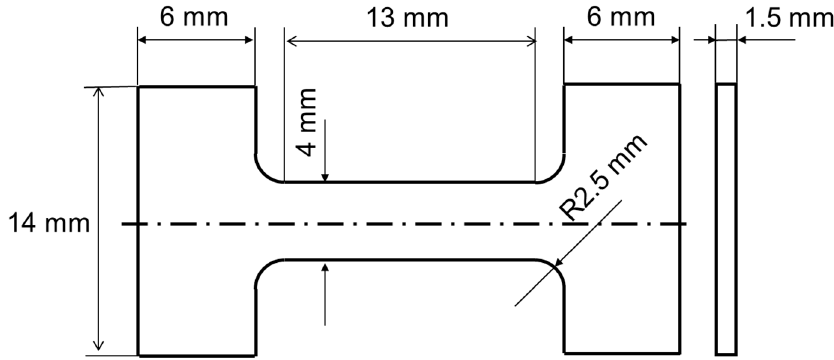
Figure 2. Dimensions of the tensile samples of the IN718 coatings.